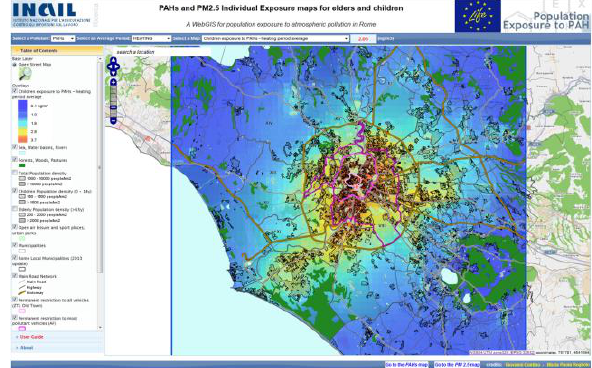
Figure 5. Screenshot of the web map illustrating elders and children exposure to PAHs and